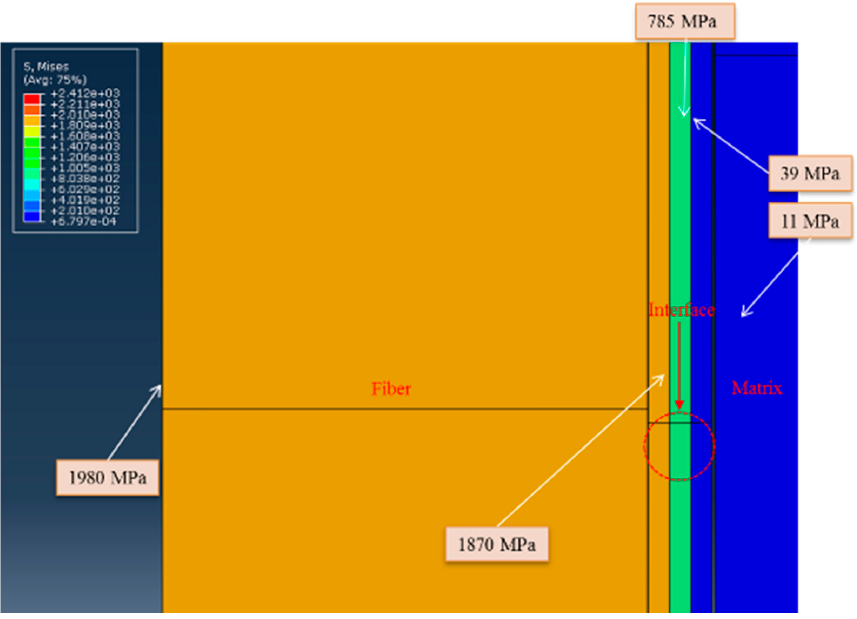
Figure 9. Stress values calculated during the simulation for each section (fiber, interface, and the matrix).